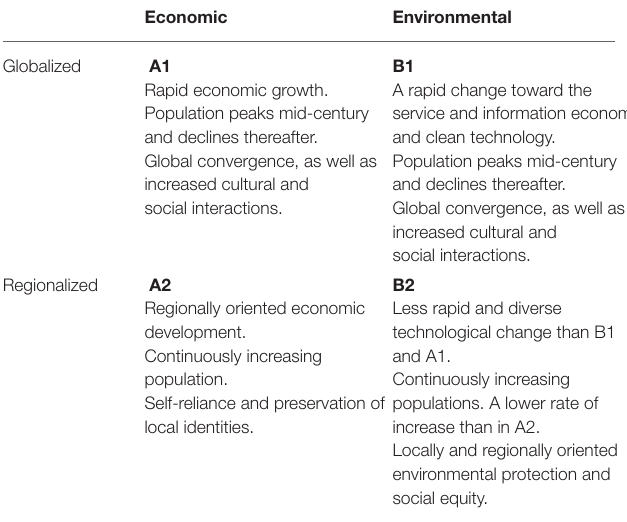
TABLE 1 | General assumptions of Special Report on Emissions Scenarios